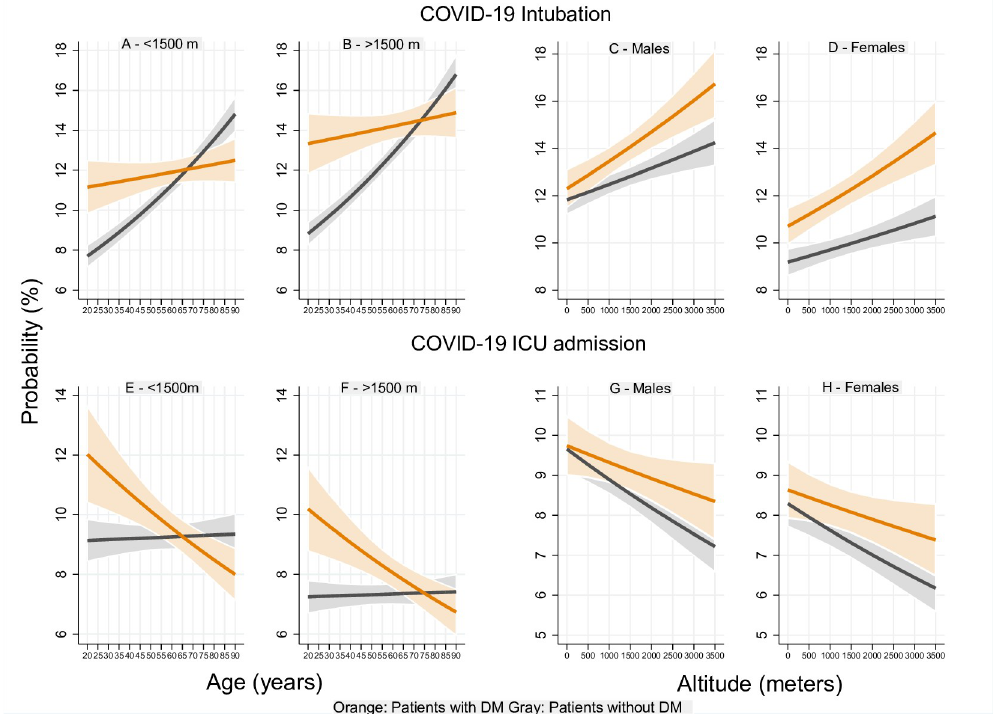
Fig 3. Event probability by age and altitude of residence in patients with COVID-19. Panel A-D show that the probability of intubation increased with age and altitude. This probability was higher for male patients [p < 0.05] and for patients with DM up to 60 [at < 1500 m] [p < 0.05] and 65 years old [at > 1500 m] [p < 0.05]. Panel E-H show that the probability of ICU admission decreased with age for patients with DM and increased for patients without DM. This probability decreased with higher altitudes. No significant differences were found between men and women with or without DM at all altitudes [p � 0.05].